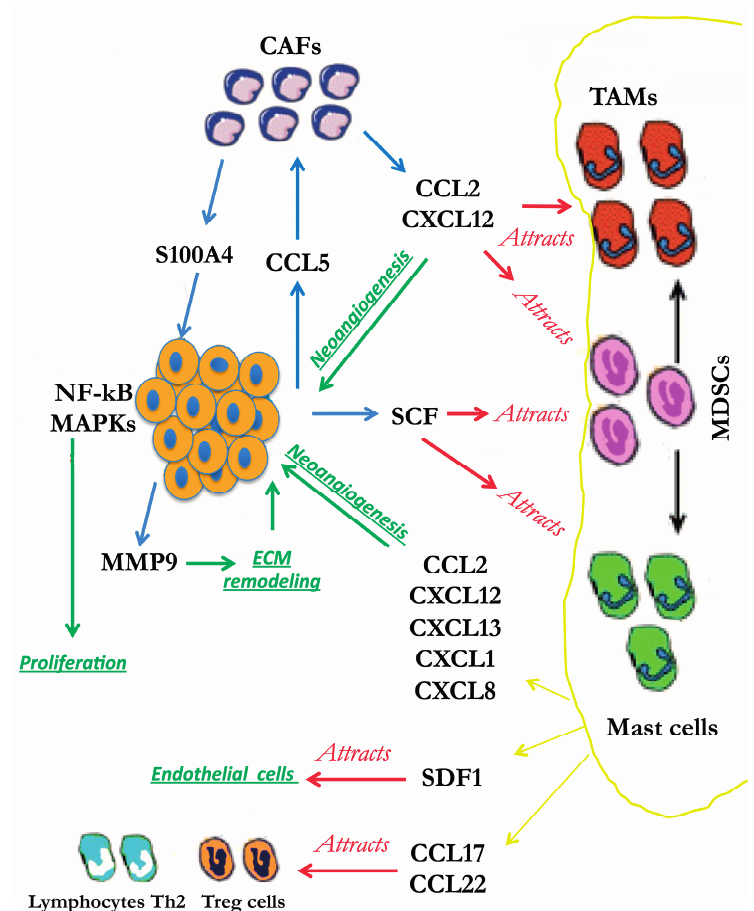
Figure 1. Formation of the tumor